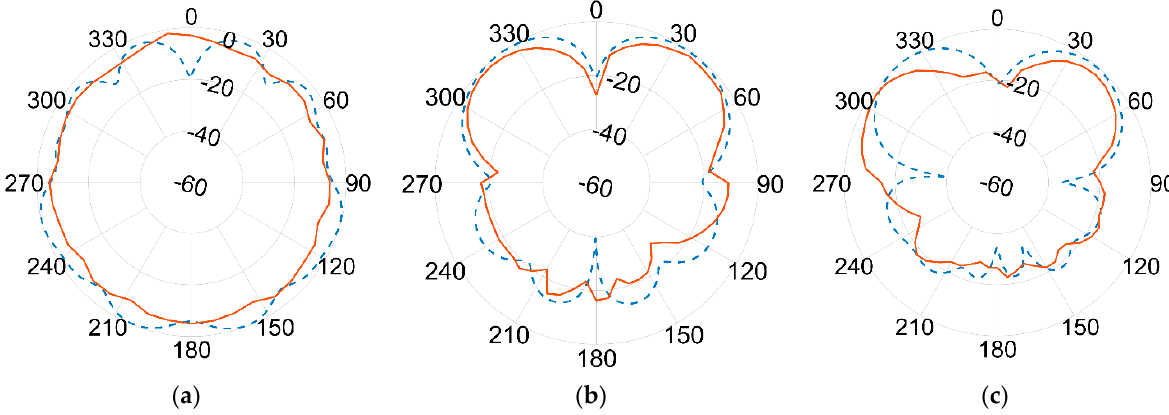
Figure 23. Normalized gain pattern of the FR-4 prototype at 1.09 GHz, ( a ) XY plane, ( b ) XZ plane, and ( c ) YZ plane— Simulated (blue dashed line) and Measured (red line) data in dB.